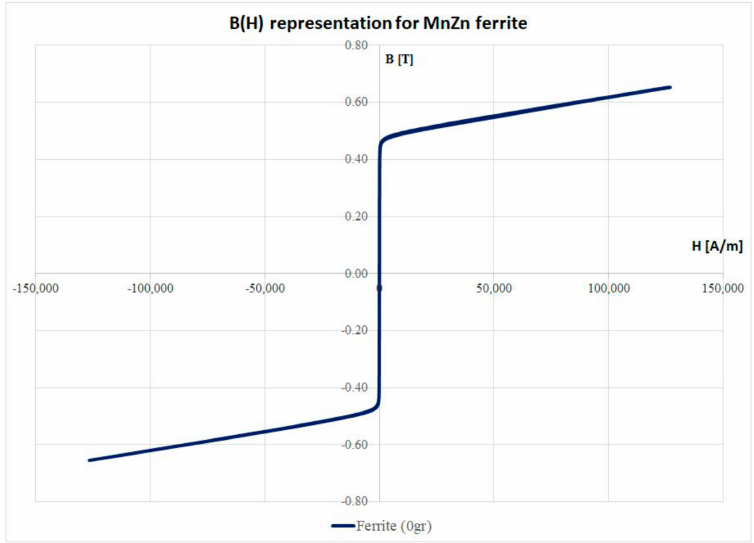
Figure 7. B(H) representation for the investigated sample.